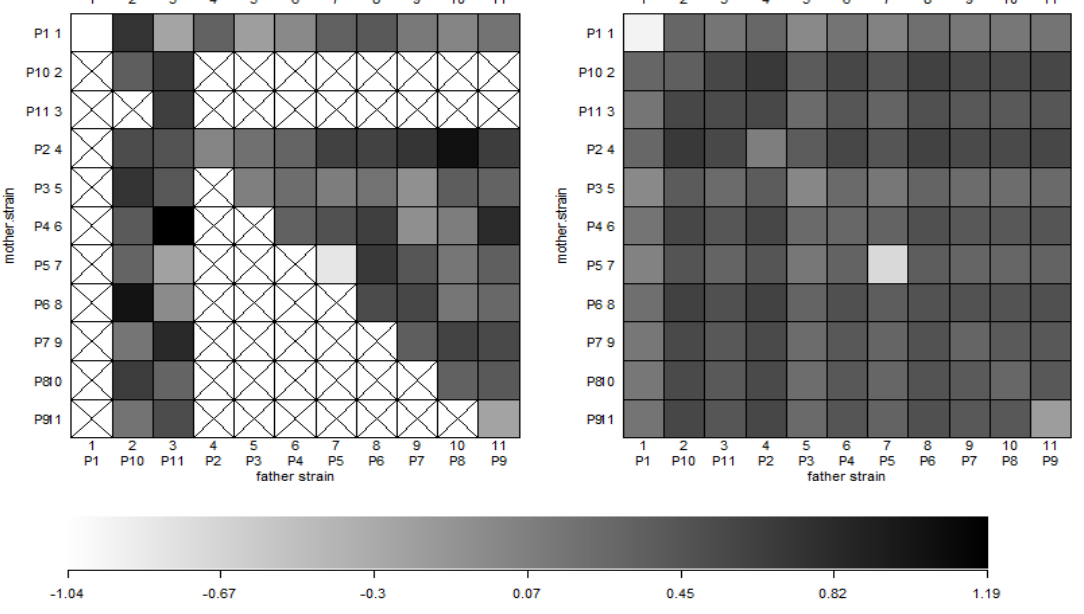
Figure 3. Total yield data of 55 hybrids and 11 parental genotypes in a half diallel. The left is for parental (P1–P11), with crossed boxes indicating the missing data (as half diallel was used) and the shaded box representing the values based on the horizontal scale (below). The right side graph shows predictive means based on the Bab diallel model on the scale of (−1.04–1.19).